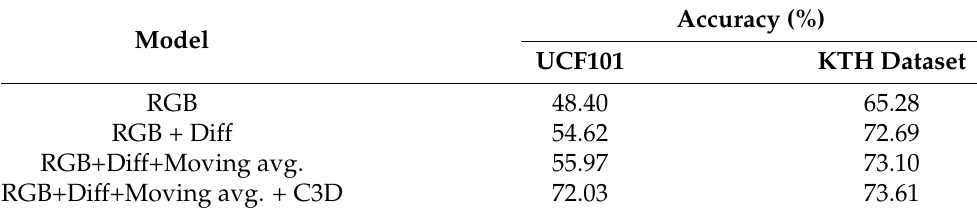
Table 1. Ablation study of the proposed